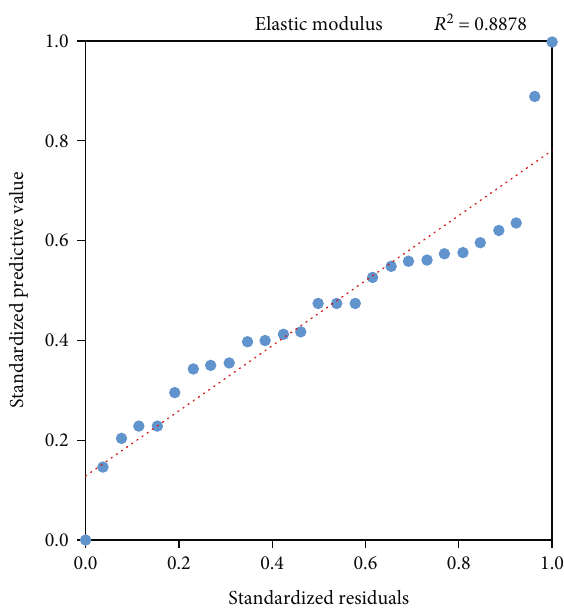
Figure 7: Probability distribution map of elastic modulus.